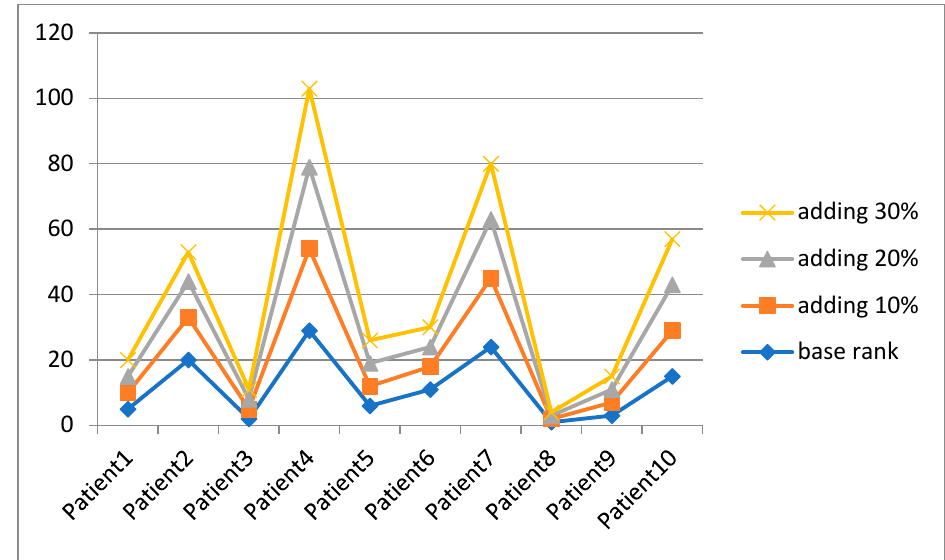
Figure 5. Sensitivity analysis on changing criteria weights by adding (10%, 20%, and 30%).